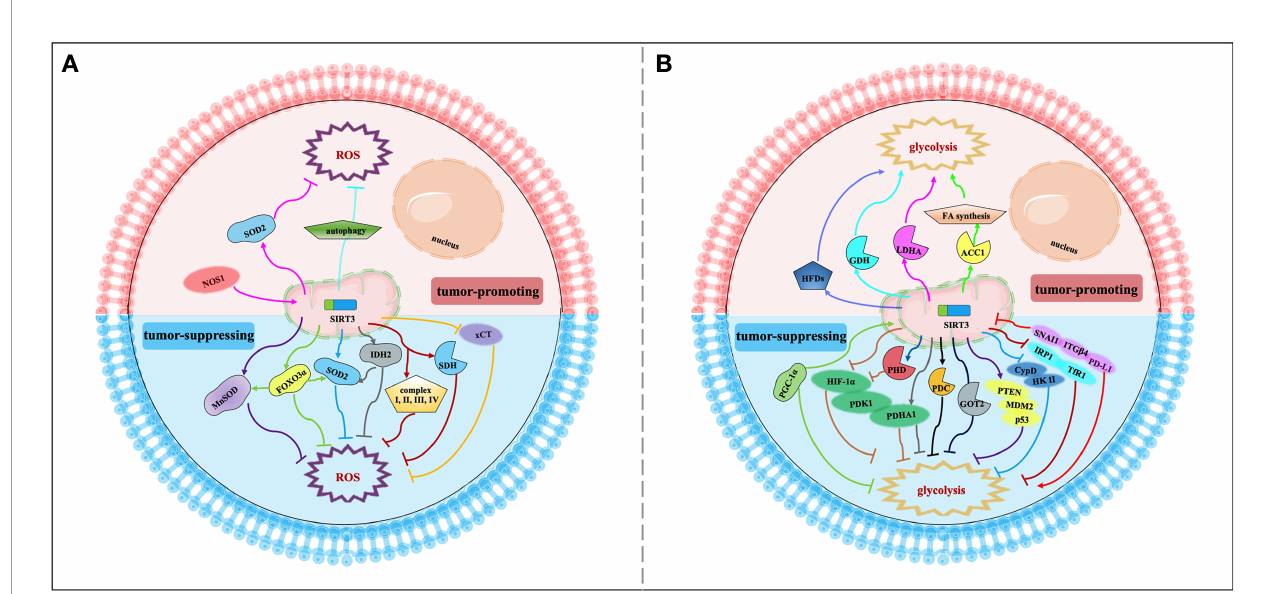
FIGURE 2 | Signaling functions of SIRT3 relevant to cancer metabolism reprogramming. (A) SIRT3 regulates cancer metabolism reprogramming by modulating ROS levels. As a tumor-suppressing protein, SIRT3 could deacetylate and modulate the activity of a series of enzymes and transcription factors such as SOD2, MnSOD, FOXO3 a , IDH2, SDH, and xCT to decrease the ROS levels and regulate tumor metabolism reprogramming. As a tumor-promoting protein, SIRT3 could regulate the NOS1/SIRT3/SOD2 pathway or mitochondrial autophagy to keep ROS at an appropriate level to promote tumorigenesis and prevent apoptosis. (B) SIRT3 regulates cancer metabolism reprogramming by modulating tumor cell glycolysis. As a tumor-suppressing protein, SIRT3 not only deacetylates and regulates the activity of various enzymes and proteins including HIF-1 a , PHD, PDHA1, GOT2, CypD, IRP1, and PGC-1 a , but also affects some signaling pathways such as HIF-1 a /PDK1/ PDHA, PTEN/MDM2/p53 pathway, CypD/HK II pathway, IRP1/TfR1 pathway, and PD-L1/ITG b 4/SNAI1 pathway, thereby inhibiting glycolysis and regulating tumor metabolism reprogramming. As a tumor-promoting protein, SIRT3 could deacetylate and activate ACC1, LDHA, GDH, and HFDs to promote glycolysis and increase the occurrence of